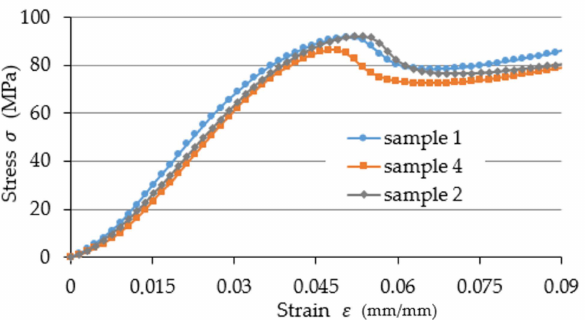
Figure 3. Examples of test results for selected (for the sake of clarity) samples of the dimensions M42 × 1.5.